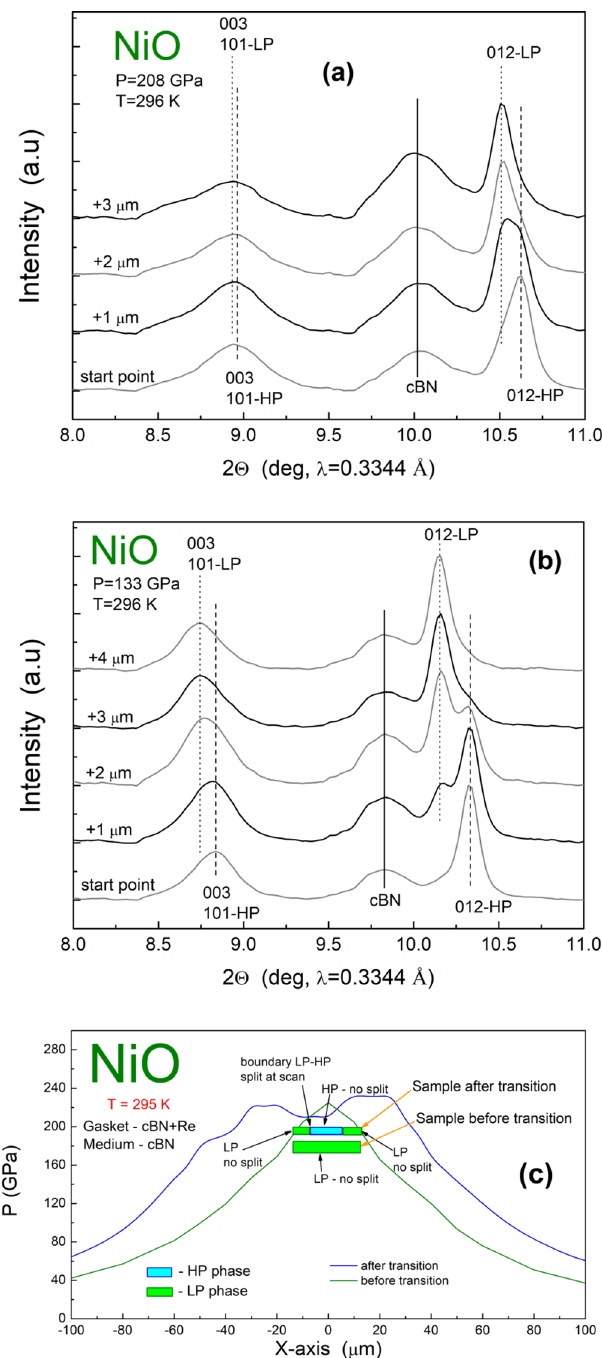
Fig. 6 The evolution of X-ray diffraction patterns along the NiO sample in a non-hydrostatic experiment at different pressures. a X-ray diffraction (XRD) patterns collected in the linear scan along the x-axis with a step of 1 µ m at 208 GPa (run5), ( b ) XRD patterns collected in the same scan at 133 GPa after decompression (run5) (Supplementary Note 3). We clearly observed the splitting of the re fl ections corresponding to simultaneous measurements of high-pressure (HP) and low-pressure (LP) structures. There is strati fi cation resulting in some regions of pure high- and low- pressure phases at the same pressure value. The scan line crosses the boundary between these two phases. The illustration of strati fi cation of LP and HP phases is shown in panel ( c